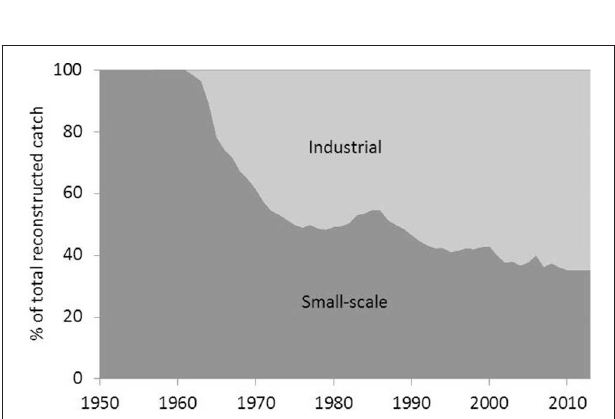
FIGURE 5 | Percentage change in small-scale and industrial sector catch contribution from 1950 to 2013.